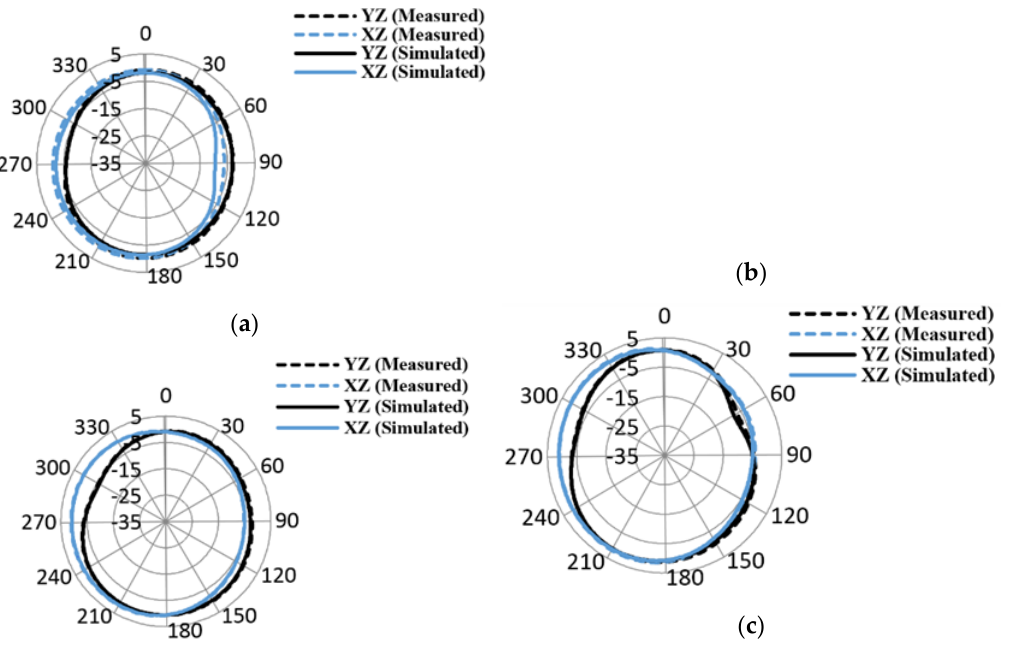
Figure 8. Measured and simulated radiation patterns ( a ) 3.3 GHz; ( b ) 5.5 GHz; and ( c ) 8 GHz.